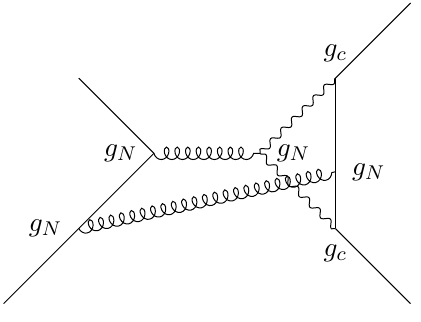
Figure 4 . Intermediate hydrodynamic state in scalar-scalar